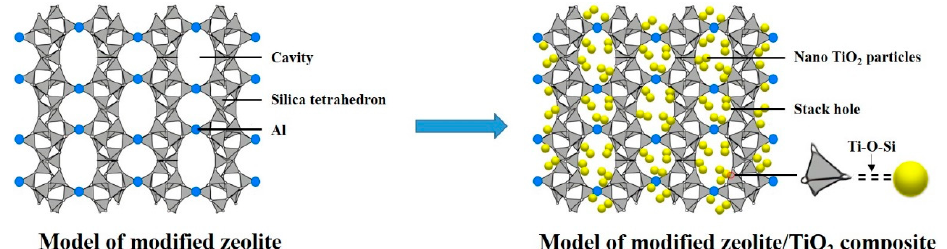
Figure 4. Models of MZ and MZTC. 139